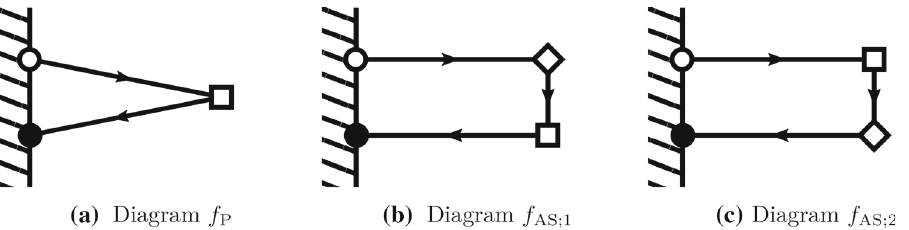
Fig. 1 The trace diagrams contributing to the expectation values of f P , defined in Eq. (B.1) ( a ) and f AS , defined in Eq. (B.3) ( b , c ). The wall represents the time slice x 0 = 0 with a γ 5 Dirac matrix between circles. The squares in the bulk represent either the insertions of a pseu- doscalar operator P ( y ) ( a ) or a scalar operator S ( y ) ( b ) and ( c ). The diamonds stand for an axial operator A 0 ( x ) . The open circles corre- Fig. 2 PCAC mass am as a function of time x 0 / a for ensembles B3k1 (left) and D1k2 (right). Squares are results obtained in the unitary setup, while diamonds are results obtained in the non-unitary setup. The final estimate for m is obtained by averaging results in the time interval [ T / 3 , 2 T / 3 ] , indicated by the dashed vertical